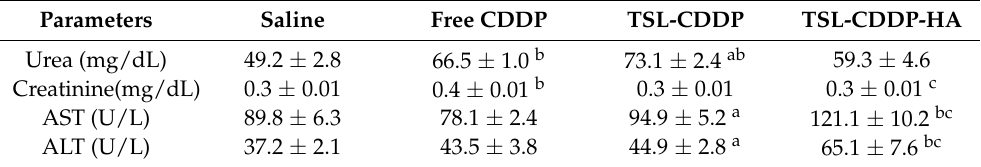
Table 5. Biochemical parameters of Swiss mice treated with saline, TSL-CDDP, TSL-CDDP-HA and free CDDP at dose of 10 mg/kg.